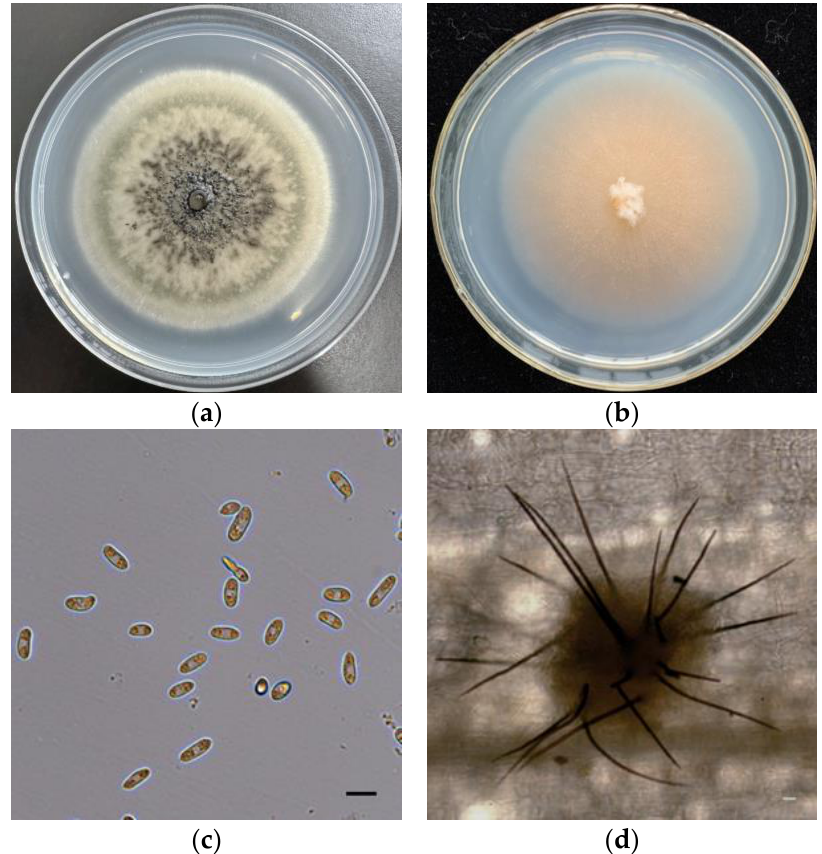
Figure 1. Morphology of C. echinochloae strain B-48. ( a , b ) Colony morphology cultured on potato dextrose agar (PDA) medium, potato sucrose agar (PSA) medium. ( c ) Morphology of conidia produced by PSA; bar scale: 10 µm. ( d ) Morphology of setae on barnyardgrass leaves; bar scale: 10 µm.